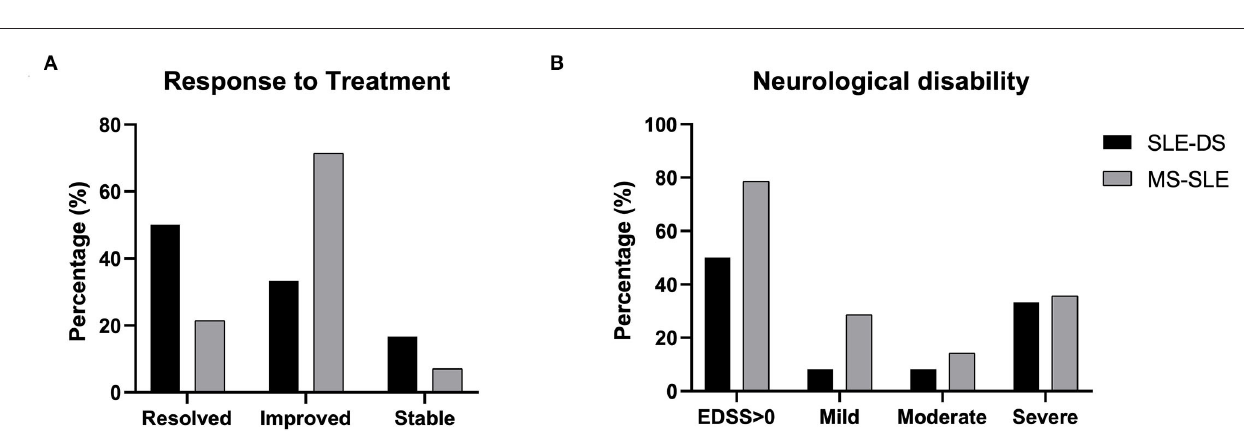
FIGURE 2 | Disease- and treatment-related outcomes at the most recent-follow up visit in patients with SLE-demyelinating syndrome and patients with overlap SLE-MS. (A) Response to treatment categorized as i) complete resolution of neurologic symptoms, ii) partial improvement of neurologic symptoms, or iii) no improvement (stable). (B) Neurological disability, as measured by the expanded disability status scale. Mild disability: EDSS ≤ 2; moderate disability: EDSS 2–4; severe disability: EDSS > 4. No significant differences were captured between the two